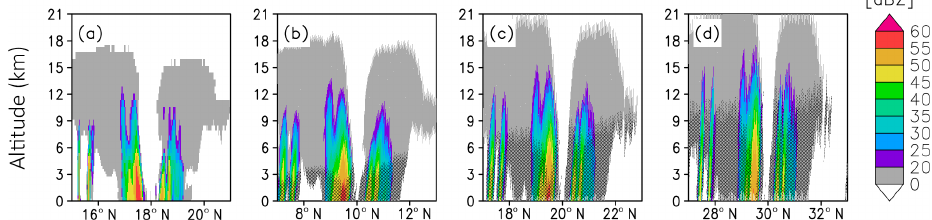
Figure 12. Precipitation reflectivity (dBZ) along the 136.4 ◦ E longitude line passing through the typhoon center measured with bw20bs05 for the typhoons whose center is in (b) 10 ◦ N, (c) 20 ◦ N, and (d) 30 ◦ N. Panel (a) shows the truth. The areas where reflectivity from precipitation<0dBZ are left blank, and the area in which SCR<0 is hatched in ( b )–( d ).